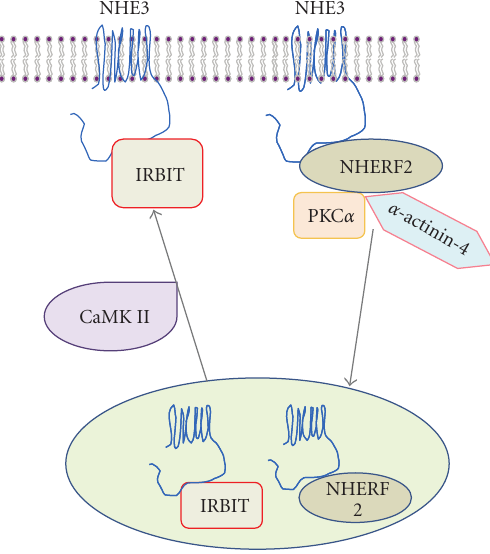
Figure 2: NHE3 can be regulated via interaction with di ff erent proteins. A tentative model of regulation of NHE3 by IRBIT and NHERF2 is shown as an example. NHE3 is retrieved into a cytoplasmic pool by a mechanism dependent on NHERF2-PKC α - actinin-4 [53]. IRBIT stimulates NHE3 activity by inducing exocytic tra ffi cking of NHE3 to the surface membrane (adapted from He et al. [111]).